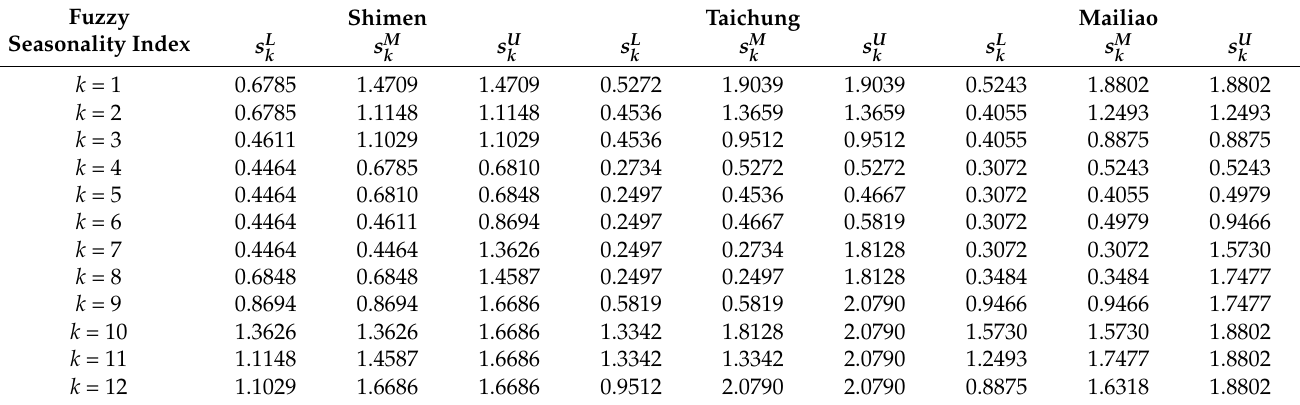
Table 3. The fuzzy seasonality index of the three wind power